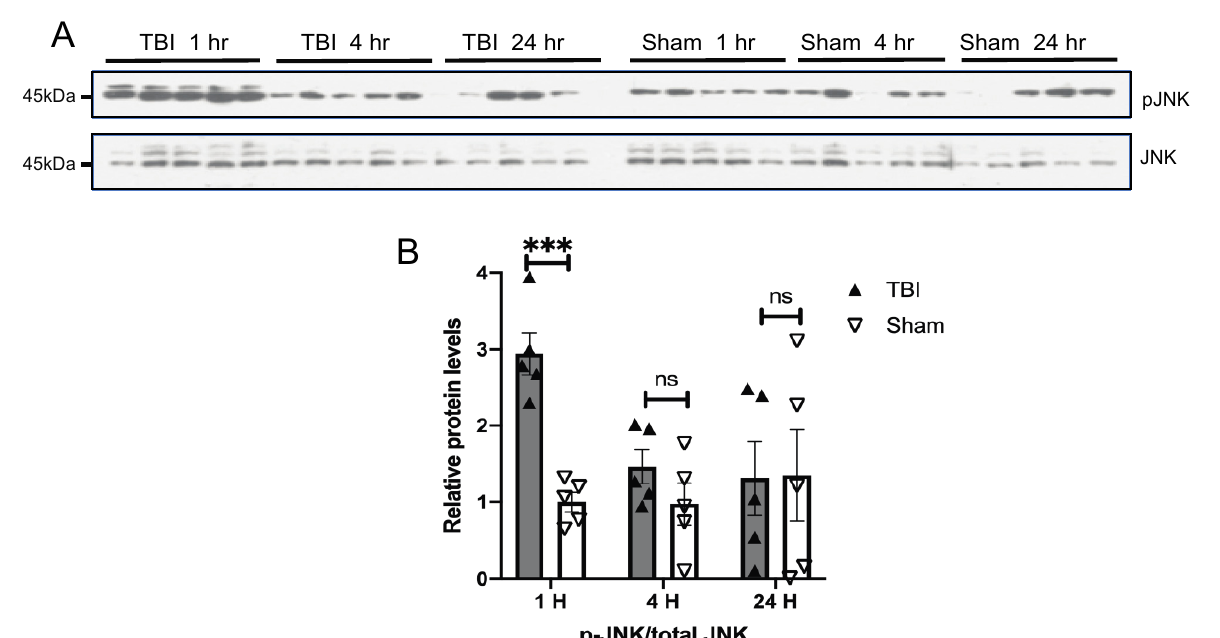
Figure 4. BOP caused the activation of extracellular signal-regulated kinase (ERK) in the mouse brain. Representative Western blots ( A ) and quantification analysis ( B ) revealed the activation of ERK after blast ( n = 5/group). (Data are means